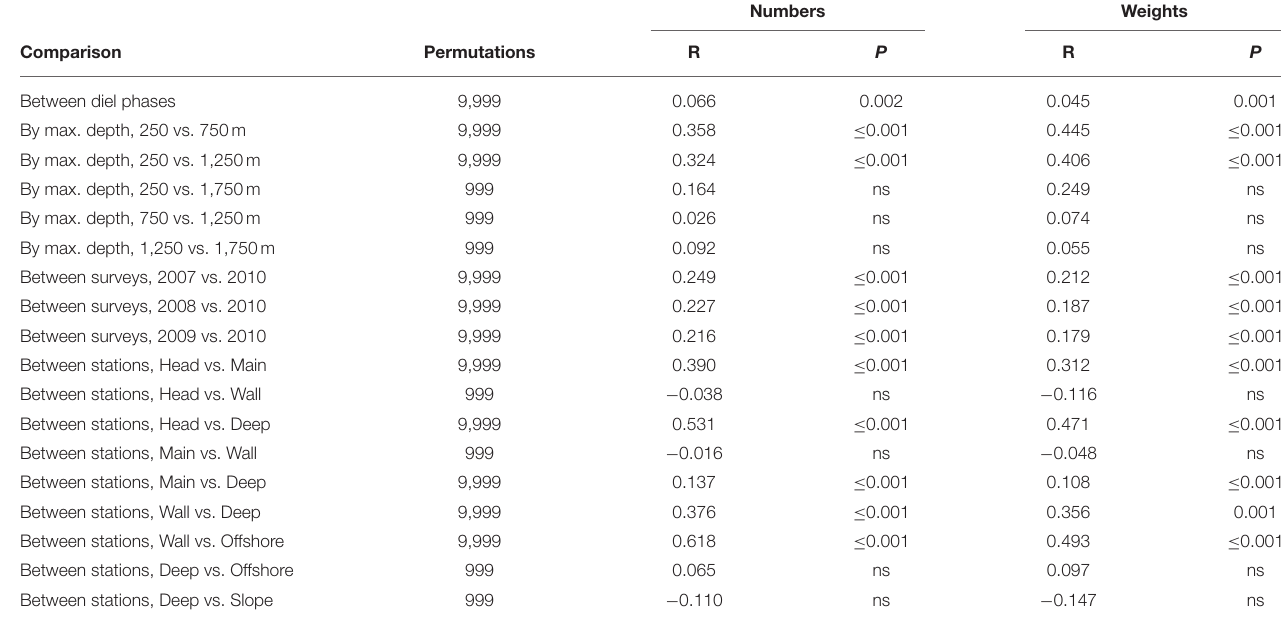
TABLE 4 | Results of pair-wise ANOSIM tests on the whole data matrices that returned P ≤ 0.01 and of selected tests which did